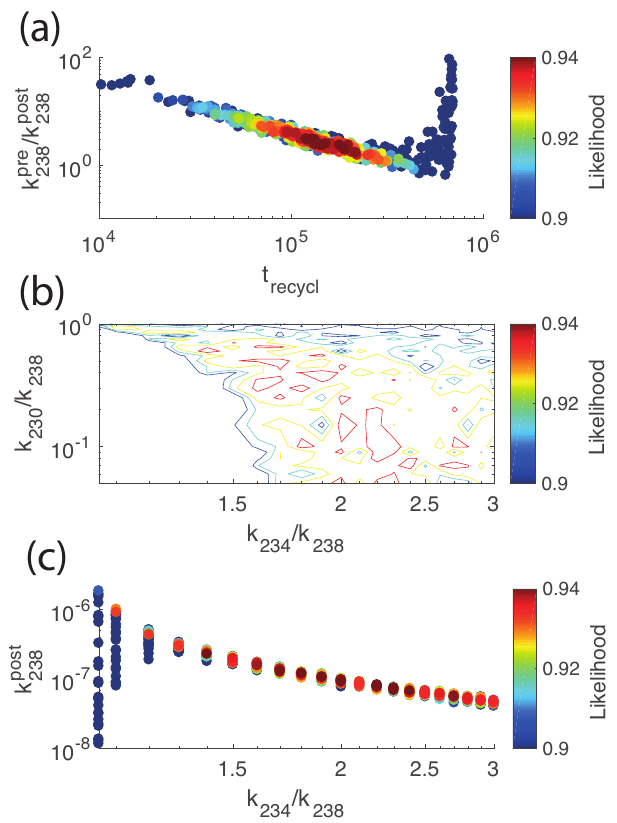
Figure 6. Results of Monte Carlo simulations for the U–Th data. The same Monte Carlo simulations were conducted for different fixed values of k 234 /k 238 and k 230 /k 238 (see Sect. 2.3.5). For each simulation we estimated the optimal solution for k pre , k post and 238 238 recycling time (pre-deposition duration, after comminution), i.e., the solution with the lowest misfit between measured and calcu- lated activity ratio data. We used this misfit to calculate a likelihood between 0 and 1 (see Eq. 5), as shown by the color map (red is lower misfit, blue is higher misfit; stretched to fit our results). The larger the likelihood, the closer to the data the solution is, so the /k post more likely the set of parameter values. (a) The ratio k pre as 238 238 a function of the recycling time. Each dot is one Monte Carlo solu- tion. The optimal solution (red dots) is for 3 times stronger weath- ering before deposition and a recycling time of 100kyr. (b) Rela- tive weathering intensities of 234 U, 238 U and 230 Th. The relative weathering intensities are poorly constrained, but a relationship can be extracted between their ratios: the larger k 234 /k 238 , the smaller k 230 /k 238 must be. (c) A relation between k post and k 234 /k 238 can 238 be extracted, even if both parameters are poorly constrained. The es- timation of sediment transfer times using U–Th disequilibria series could be improved with better constraints on the relative mobility of 234 U and 238 U.